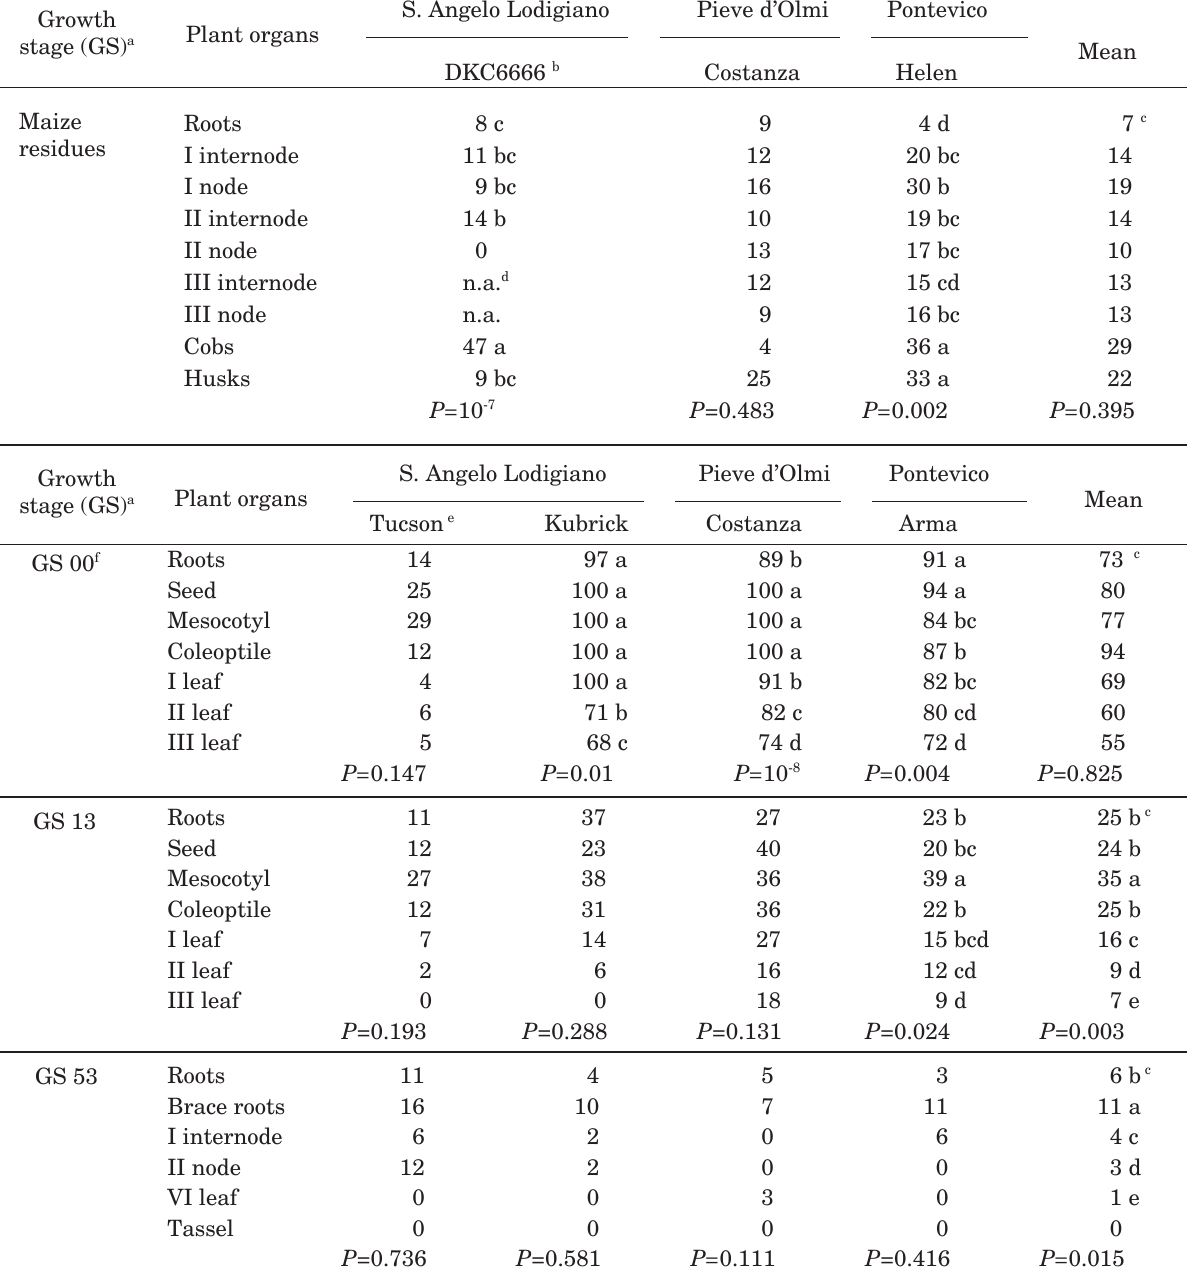
Table 2. Fusarium verticillioides isolation frequencies (IFs) in different plant organs during different maize growing stages: IFs in crop residue organs; IFs in seedlings grown in aseptic conditions; IFs in seedlings grown in the field; IFs in plants before silking; IFs in fully ripe plants and ears. Each value represents the average IFs of 30 plants. Within each hybrid and within each growth stage (GS), values with different letters indicate significantly different values at P ≤0.05 (Tukey’s test). Absence of letters indicates no significant